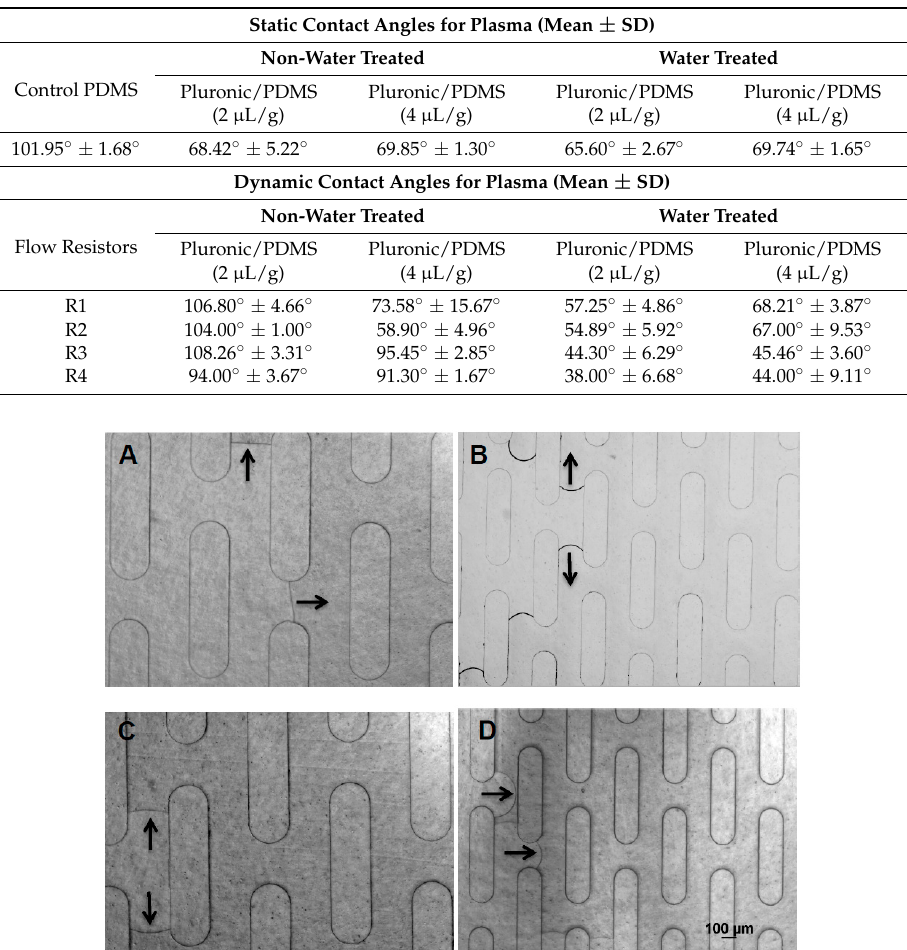
Figure 2. Representative images show the measured contact angles of human plasma on different surfaces. ( A ) Contact angle of 10 μ L droplet of plasma on a surface of PDMS (control); ( B ) The static contact angle of a 10 μ L droplet of plasma on Pluronic functionalized PDMS (4 μ L/g); ( C ) The dynamic contact angle of plasma running through a resistor channel. The arrow indicates the flow direction. Table 3. Measured static and dynamic contact angles of plasma.